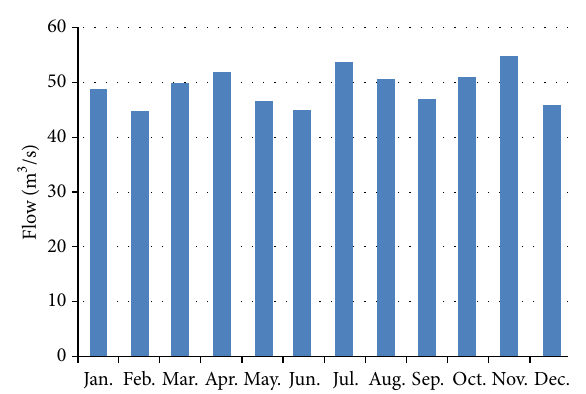
Figure 3: Average water flow per